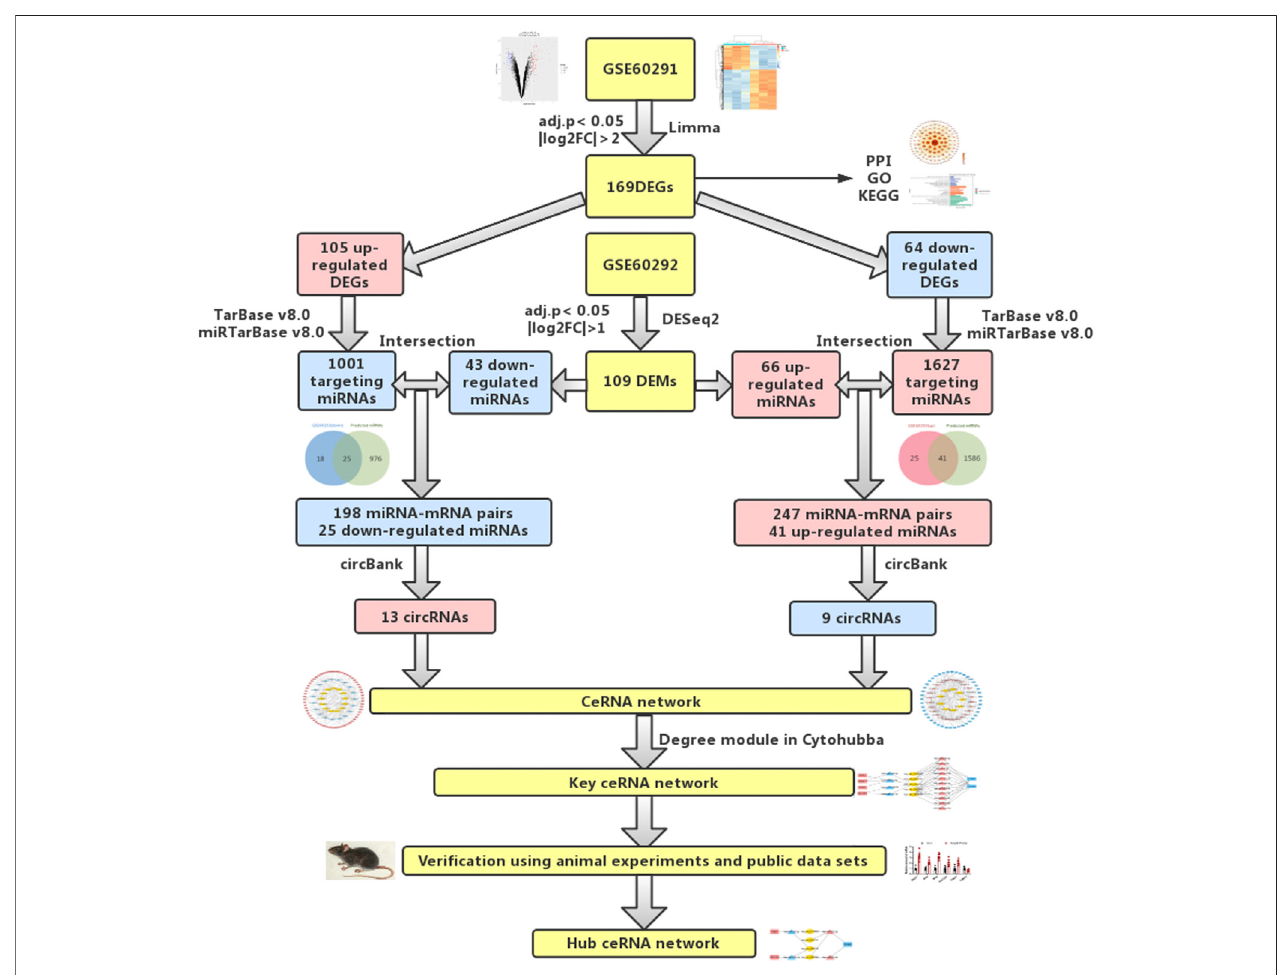
FIGURE 1 | Flowchart of bioinformatics analysis: data collection, processing, analysis, and validation. We screened out differentially expressed mRNAs and miRNAs from public databases. According to online prediction websites, we fi nally obtained relevant circRNAs and established circRNA-related ceRNA regulatory networks. To verify our results, PCR was used to verify differentially expressed mRNAs and miRNAs in animal cardiac hypertrophy model samples.